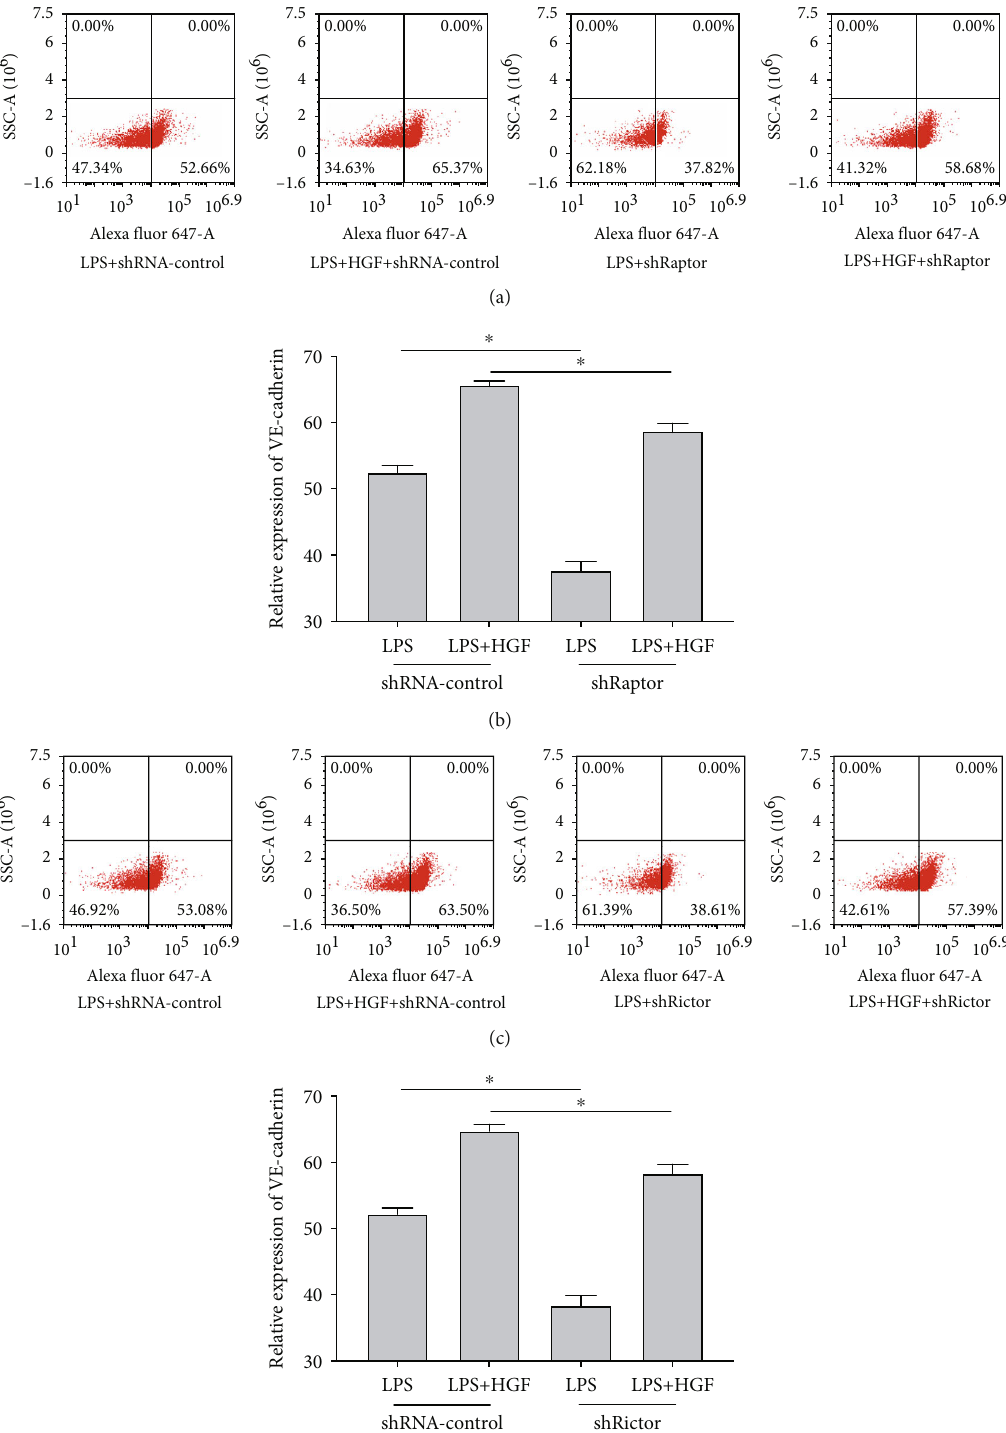
Figure 3: E ff ects of mTORC1 and mTORC2 to HGF on VE-cadherin expression in LPS-induced PMVEC barrier. Lentivirus vector- mediated raptor and rictor knockdown in PMVECs (shRaptor and shRictor as knockdown, shRNA-control as negative control) was conducted. PMVECs were treated with HGF (20 ng/ml), with or without stimulation with LPS (100ng/ml) for 4h. (a) Flow cytometry scatter plot of 4 h VE-cadherin expression with HGF in LPS-induced PMVEC-shRaptor. (b) Flow cytometry cell counts (%) of 4 h VE- cadherin expression with HGF in LPS-induced PMVEC-shRaptor. (c) Flow cytometry scatter plot of 4h VE-cadherin expression with HGF in LPS-induced PMVEC-shRictor. (d) Flow cytometry cell counts (%) of 4 h VE-cadherin expression with HGF in LPS-induced PMVEC-shRictor. Results are mean ± SD ( n = 3 ). ∗ p < 0 : 05